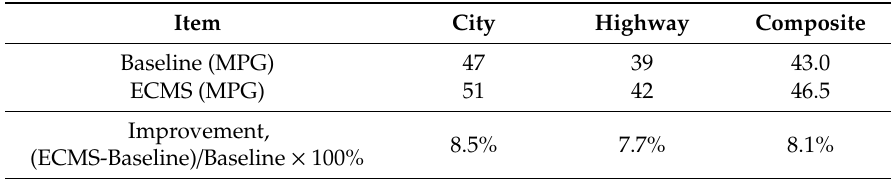
Table5. Comparisonoffuelconsumptionbetweenthebaselineandequivalentcombustionminimization strategy (ECMS).